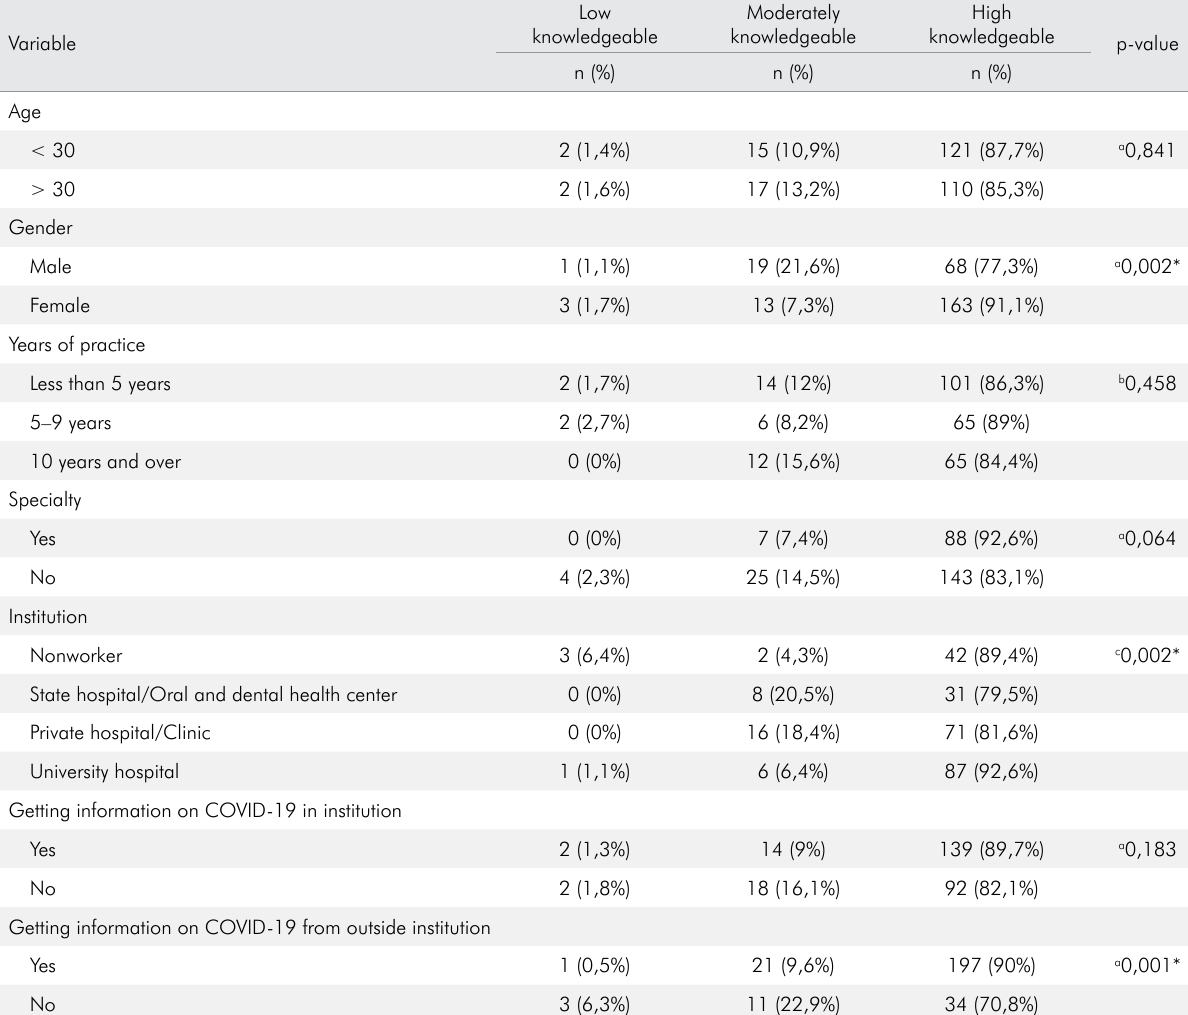
Table 6. Association between dentists’ characteristics and COVID-19 knowledge